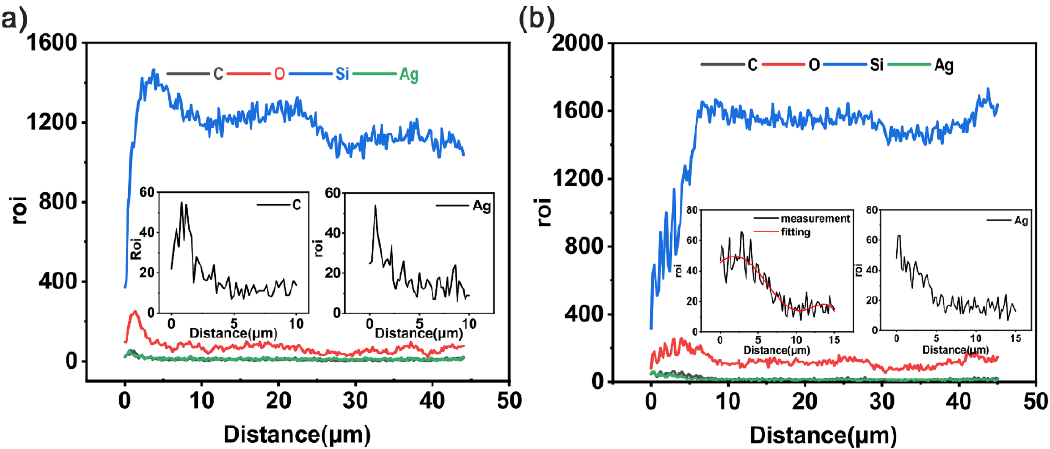
Figure 11. ( a ) EDS image of the cross section of sample 3. ( b ) EDS image of the cross section of sample 4.